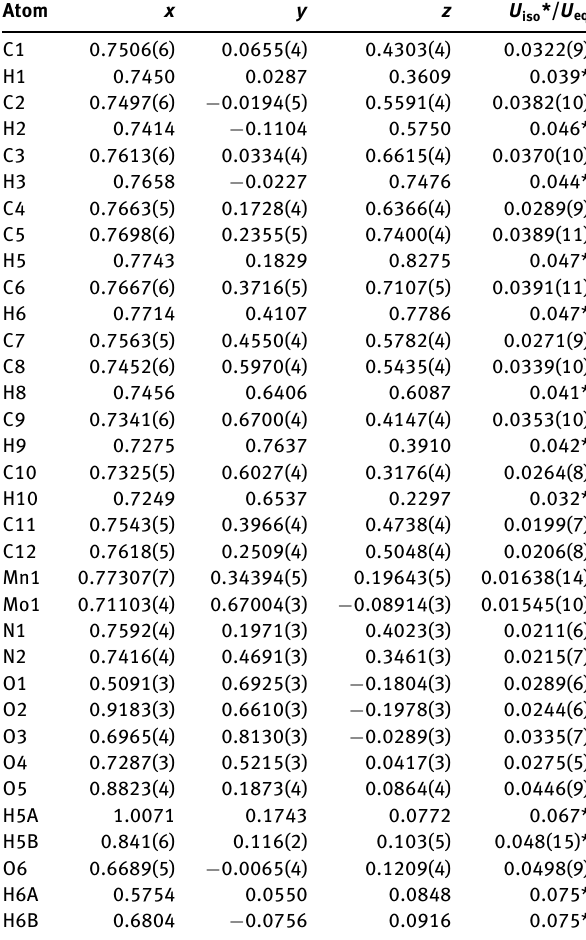
Table 2: Fractional atomic coordinates and isotropic or equivalent isotropic displacement parameters (Å 2